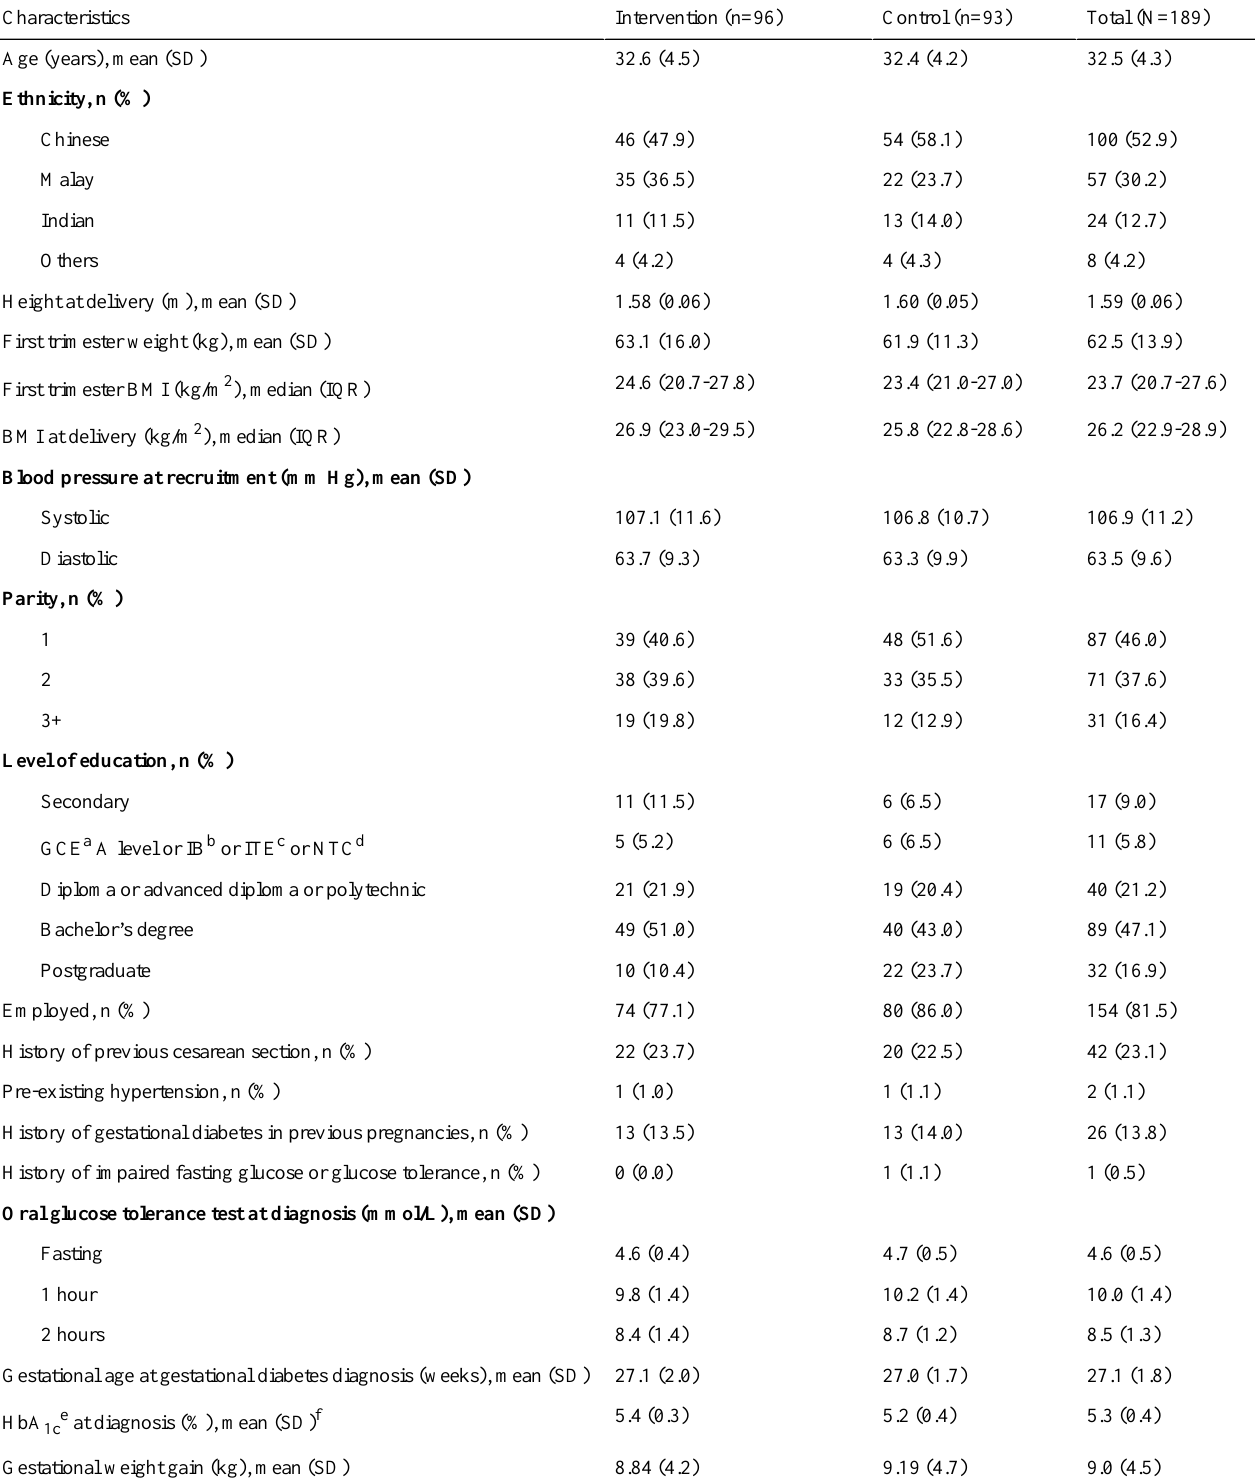
Table 1. Demographics and clinical characteristics of trial